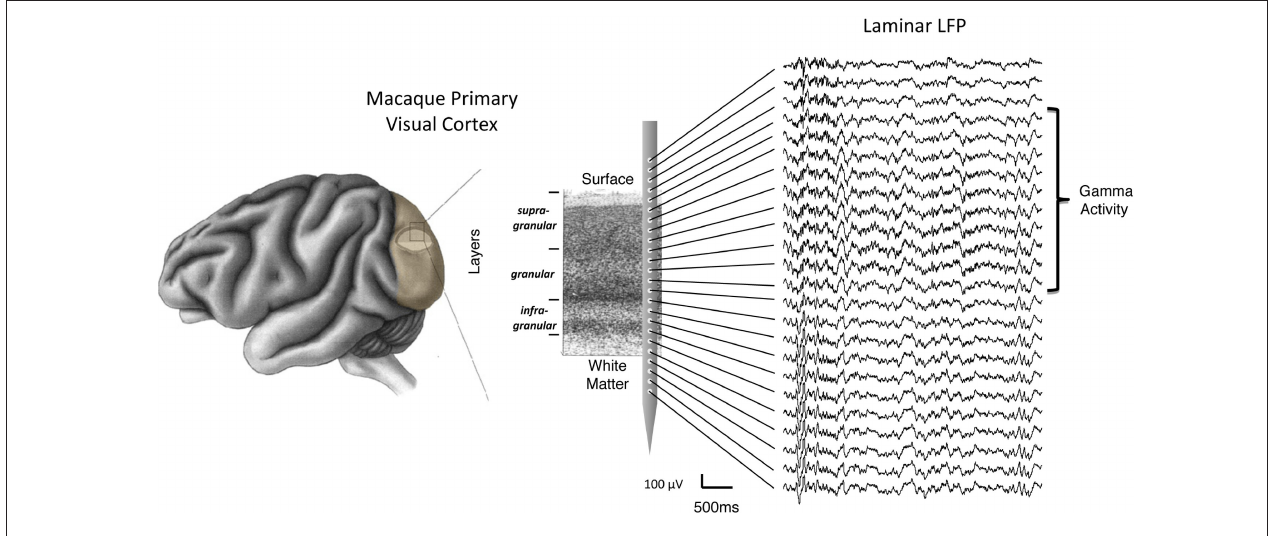
of extracellular LFP data collected in one experiment. Each trace corresponds to the voltage measured simultaneously as a function of time (see scale bar). In this example, the top contacts span an area reaching from outside the brain (top) to the white matter (bottom). Note the spatial non-uniformity of gamma frequency signals, superimposed on the signals, and restricted to the upper cortical